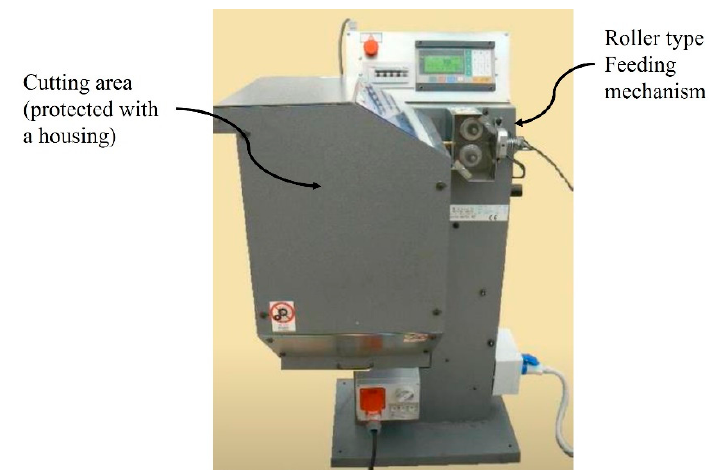
Figure 2. Example of cutting machinery already in use in the facilities.